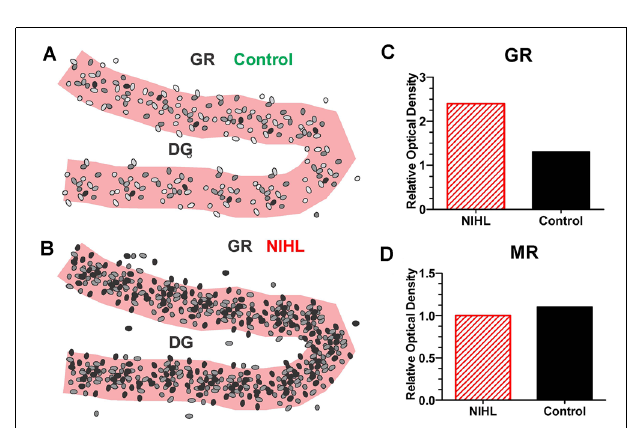
FIGURE 5 | Severe NIHL alters glucocorticoid receptor (GR) expression in hippocampus. (A) Schematic of dentate gyrus (DG) in hippocampus showing immunolabeling of GR receptors (black, gray round, oval symbols schematically illustrate the relative intensity of immunolabeling.) in normal control. (B) Schematic of DG in hippocampus showing GR immunolabeling several months after induction of severe unilateral noise-induced hearing loss (NIHL; 126 dB SPL, 2 h, NBN centered at 12 kHz). (C) Schematic of relative optical density of GR immunolabeling in DG in rats with severe chronic NIHL compared to controls. (D) Schematic of relative optical density of mineralocorticoid receptor (MR) immunolabeling of rats with chronic NIHL compared to